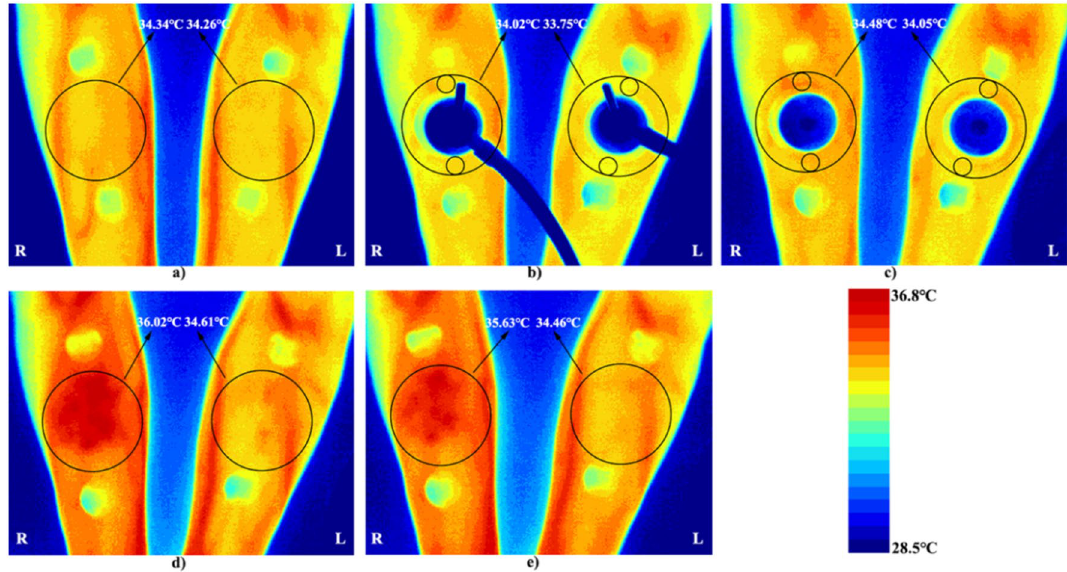
Figure 3. Measurement of the skin temperature of the cupping site at different stages of the experiment using IRT. ROIs are marked with black circles. ( a ) The basal temperature before cupping is measured. ( b ) Cupping is started at − 0.03 MPa on the left and − 0.04 MPa on the right. The mean temperature in the ROI is represented by the average temperature of two small circular regions. ( c ) Cupping is maintained. ( d ) 500 s after cupping. ( e ) 1800 s after cupping. R right, L